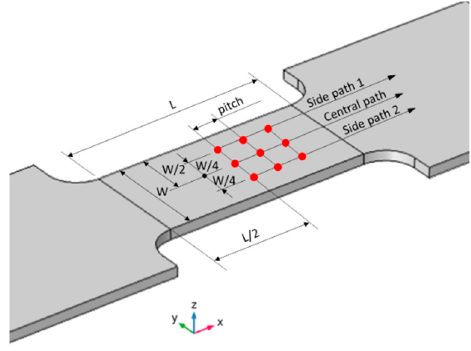
Figure 14. Microhardness test scheme.